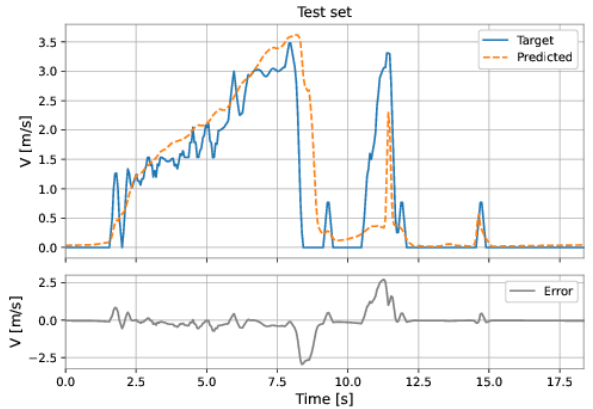
Figure 51. MLP’s predictions on the training set.